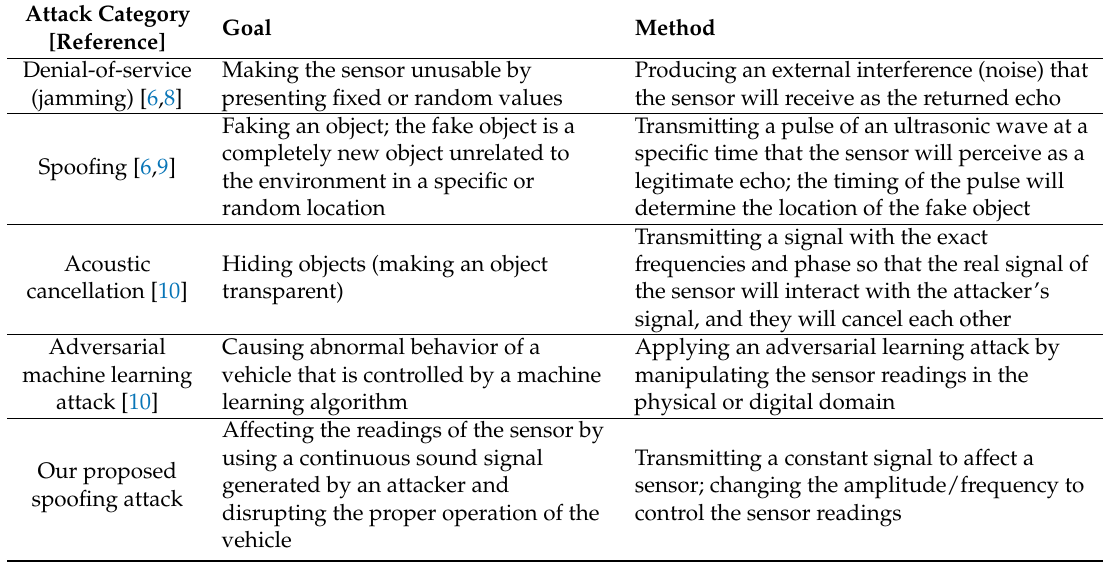
Table 1. Summary of previous work related to attacks on ultrasonic distance sensors as well as our proposed